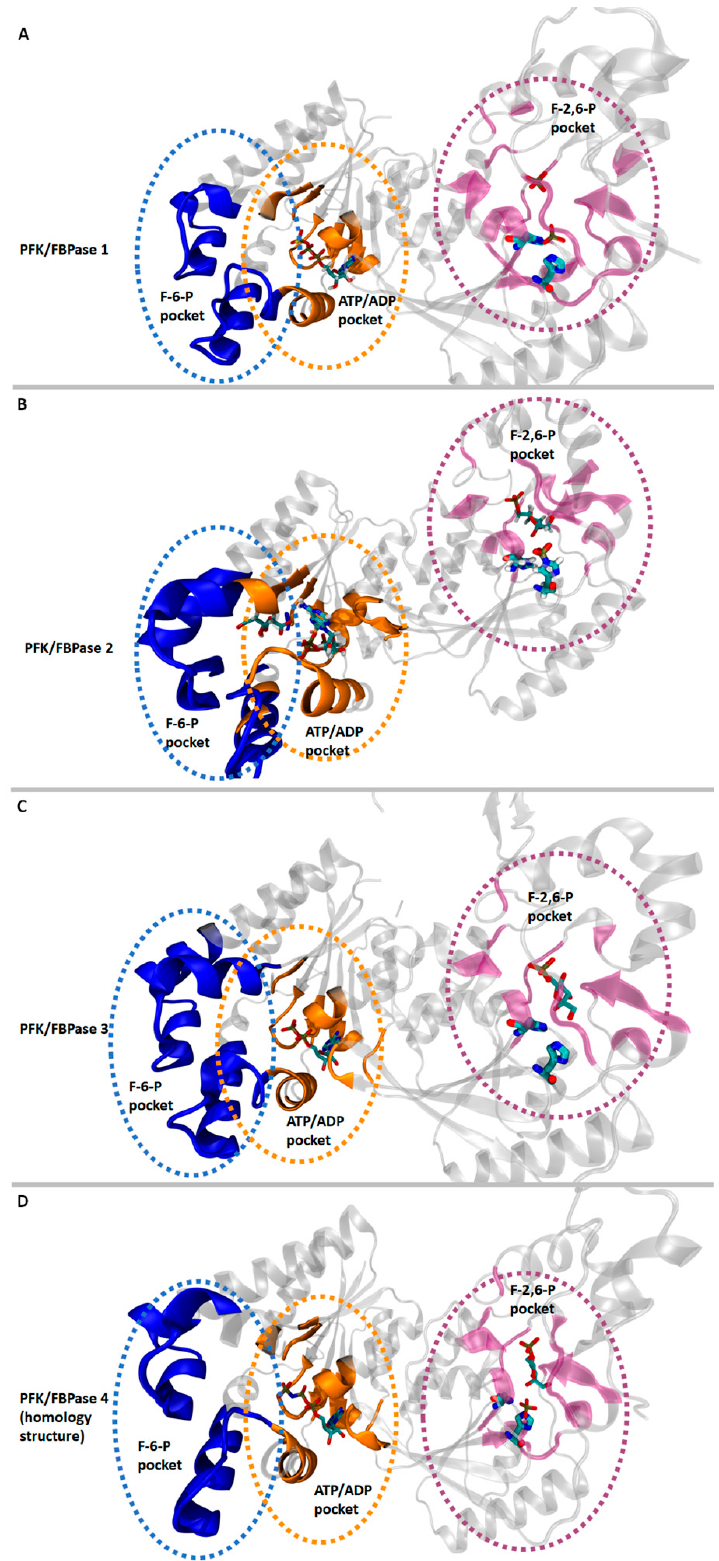
Figure 6. Binding pockets for human 6-phosphofructo-2-kinase/fructose-2,6-bisphosphatase (PFK-2/FBPase-2) isozymes 1 to 4. 2-Kase and 2-Pase domains are shown on the left and right, respectively (as in Figure 5). The subfigures ( A – D ) depict PFKFB1, PFBFB2, PFKFB3 and PFKFB4